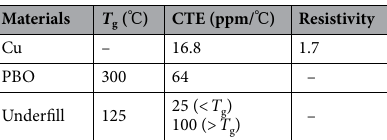
Table 2. Material properties employed in the FEM analysis.